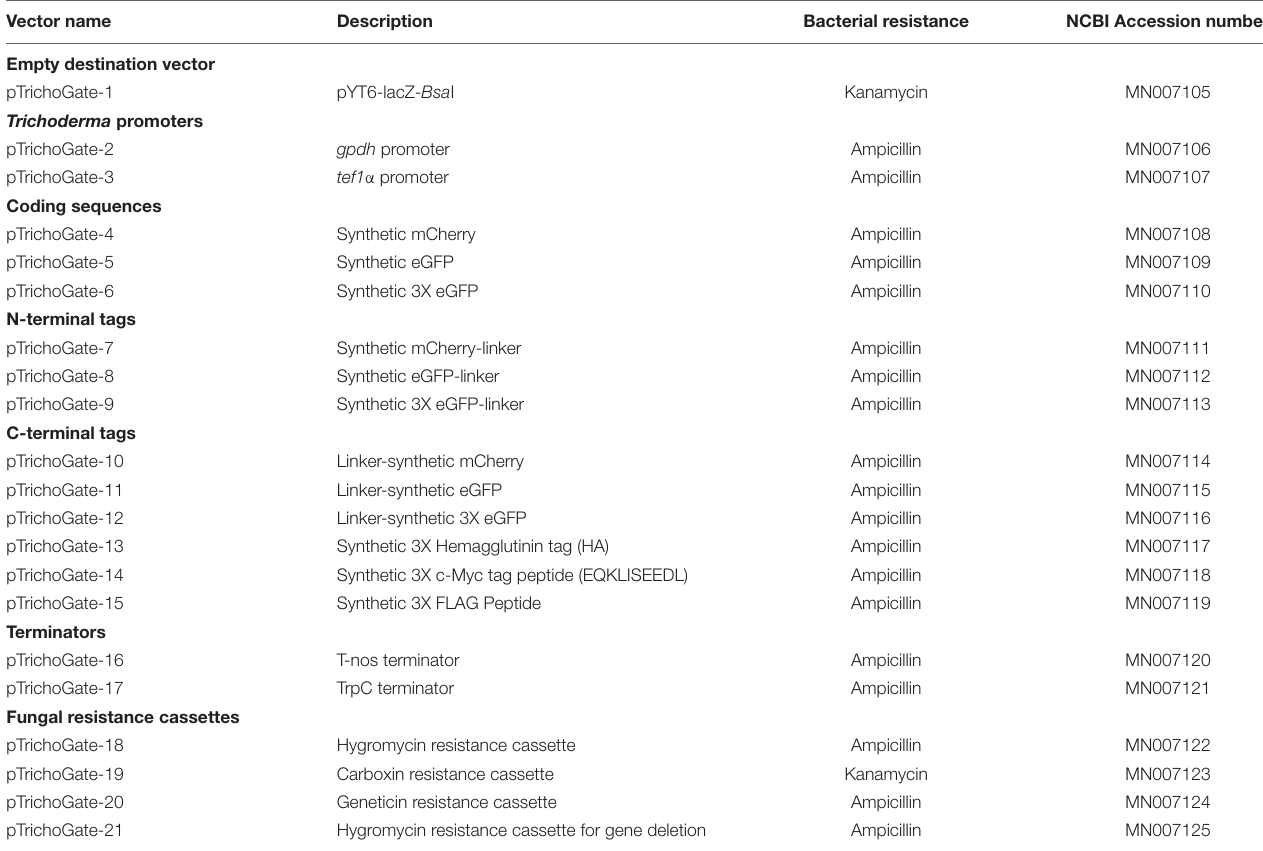
TABLE 1 | Entry and destination vectors optimized for functional genetics in